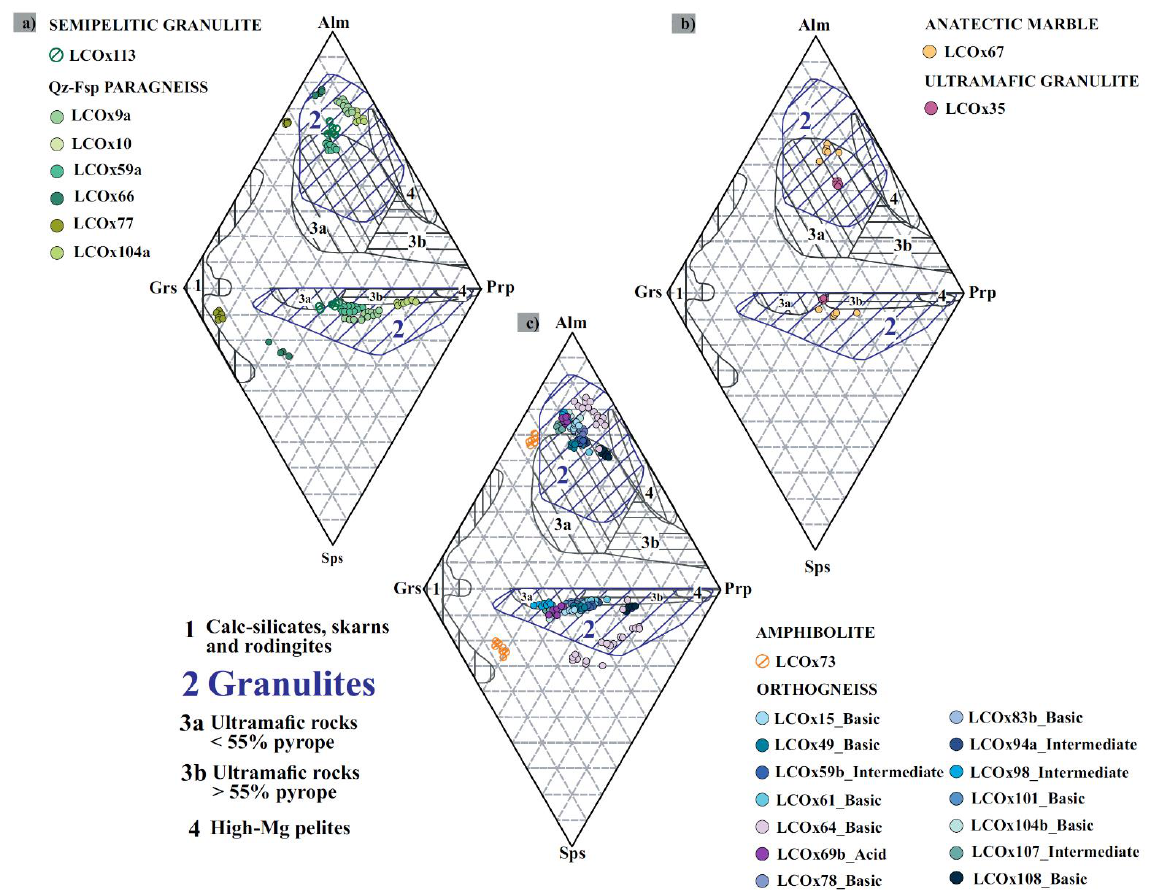
Figure 5. Ternary plots based on the molar ratio of Grt main end members Alm (almandine), Prp (pyrope), Grs (grossular), and Sps (spessartine): ( a ) Ternary plot of Grts from semipelitic and Qz-Fsp paragneiss lithotypes; ( b ) Ternary plot of Grts from anatectic marble and ultramafic granulite lithotypes; ( c ) Ternary plot of Grts from basic, intermediate, and acid orthogneiss lithotypes. Modified from [43].